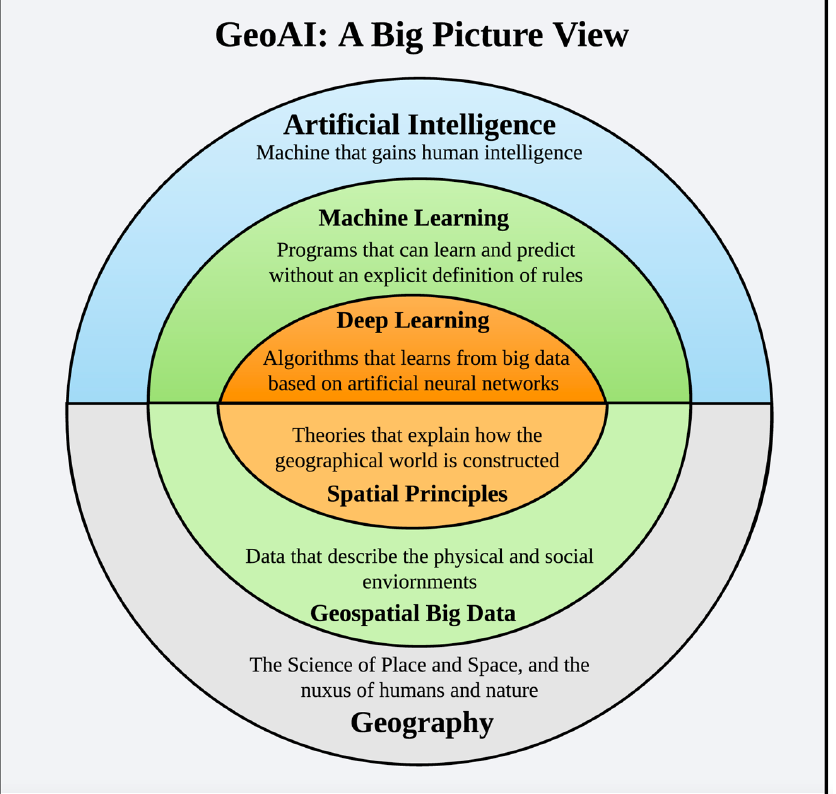
Figure 1. A big picture view of GeoAI.